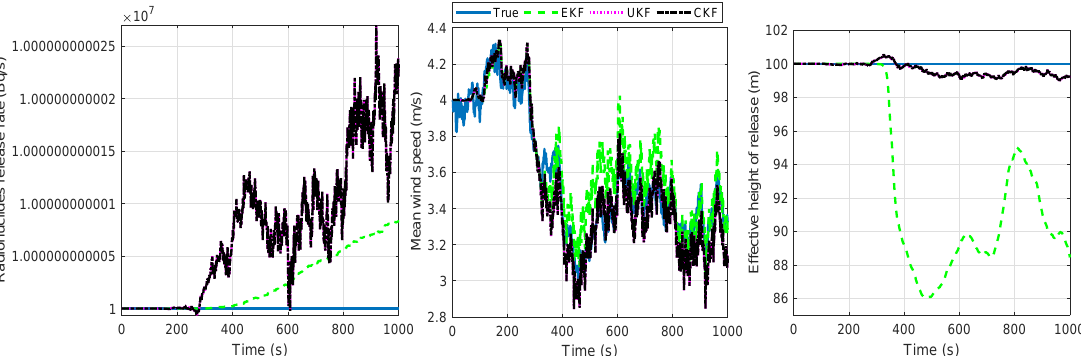
Figure 10. True and estimated release rate, wind speed, and height of release for variation in atmospheric condition.